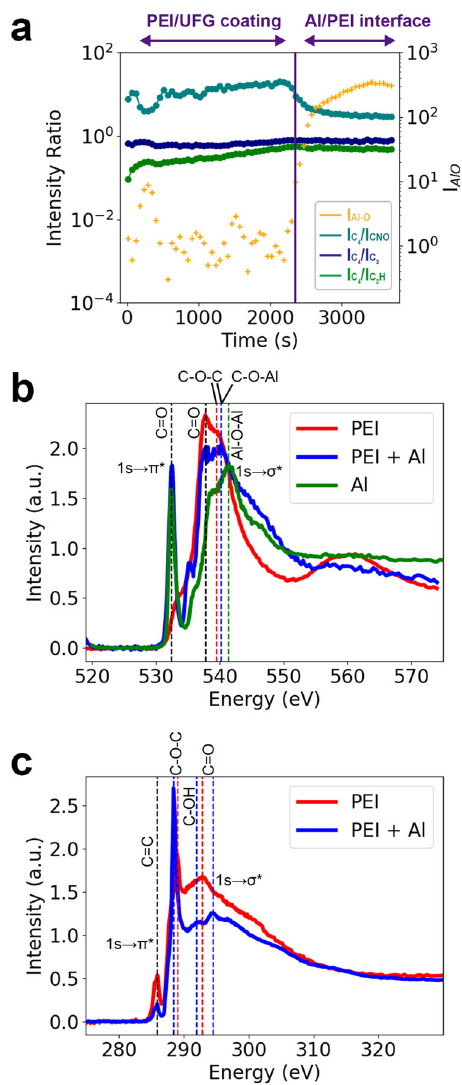
Fig. 2 Investigation of Interfacial Interactions Between UFG/PEI Nanocomposite Coatings and AA 7075 Substrates. a ToF-SIMS depth pro fi le illuminating strong Al — O signals at the metal/coating interface; XANES spectra acquired at ( b ) oxygen and ( c ) carbon K-edges for PEI, PEI interfaced with Al fl akes, and the Al fl akes to investigate the binding mechanisms between the PEI and aluminum substrate. Peak assignments are noted in the spectra and are further discussed in the